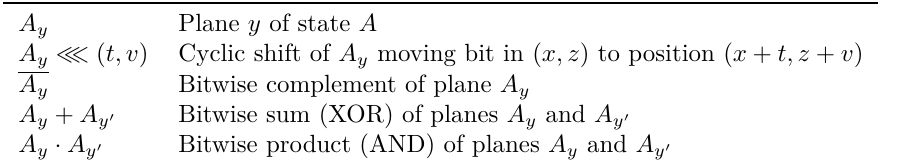
Table 1: Notational conventions